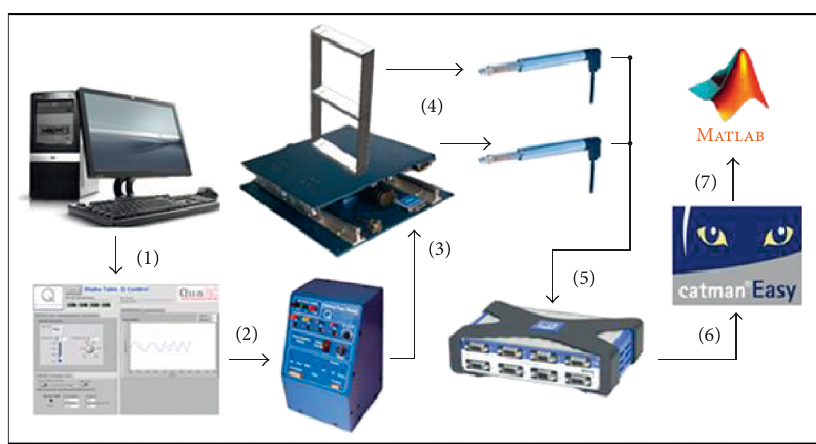
Figure 9: Representation of the experimental procedure under forced